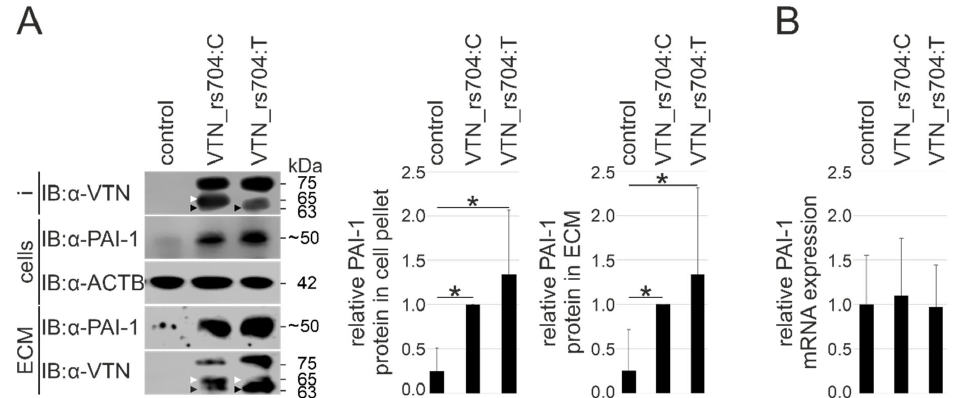
Figure 3. Effect of vitronectin isoforms on endogenous endothelial PAI ‐ 1 protein expression and deposition. HUVECs were incubated for 24 h with input (i) including VTN_rs704: C, VTN_rs704: T, or the same volume of control eluate (control), respectively. ( A ) Input, cells and ECMs were sub ‐ jected to immunoblot (IB) analysis with antibodies against vitronectin, PAI ‐ 1 and ACTB. Endoge ‐ nous PAI ‐ 1 is recognizable as a major molecular weight species of approximately 50 kDa, consistent with previous reports of glycosylated PAI ‐ 1 as a 50–54 kDa molecular weight species [46,47]. Ar ‐ rowheads indicate different fractions of recombinant vitronectin after its proteolytic cleavages (white arrows: cleavage between aa Arg398 and Ala399, black arrows: cleavage between aa Arg380 and Ser381) by endogenously expressed endoproteases. In contrast to VTN_rs704: C that stains as a mixture of a single polypeptide chain (about 75 kDa) and a clipped form (two chains of 65 and 10 kDa, held together by disulfide bonds, with the 10 kDa chain not detectable within this experimental setup), VTN_rs704: T is less susceptible to the proteolytic cleavage at Arg398 ‐ Ala399 indicated by a higher proportion of the uncleaved 75 kDa protein [8,32]. Molecular weights of approximately 63 kDa (black arrows) depict vitronectin fragments resulting from cleavage at Arg380 ‐ Ser381, as de ‐ scribed in [50]. PAI ‐ 1 signals were densitometrically quantified and normalized against ACTB. Data represent the mean ± SD of nine biological replicates, calibrated against the PAI ‐ 1 signals obtained after VTN_rs704: C addition. Asterisks indicate statistically significant differences (* p < 0.05, Krus ‐ kal–Wallis test, followed by Dunn’s multiple comparison test with Bonferroni correction). ( B ) mRNA was isolated and PAI ‐ 1 expression determined by qRT ‐ PCR. Data represent the mean ± SD of six biological replicates, calibrated against the control. Furthermore, the effect of VTN_rs704: C and VTN_rs704: T on PAI ‐ 1 deposition to the ECM was also explored in an alternative cell type: the RPE ‐ derived cell line ARPE ‐ 19 [51]. Cells were transfected with expression vectors for the two untagged vitronectin isoforms, or with an empty control vector, and incubated on transwell filters for 8 weeks. After immunolabeling, decellularized ECM produced by ARPE ‐ 19 cells heterologously expressing vitronectin showed an approximately 3 ‐ fold increase in PAI ‐ 1 protein expres ‐ sion (3.03 ± 1.73 with VTN_rs704: C, 2.59 ± 0.91 with VTN_rs704: T, compared to control; Bonferroni ‐ adjusted p < 0.05 between control and VTN_rs704: C or VTN_rs704: T; Figure 4). The ECMs revealed an increased accumulation of vitronectin (Figure 4), which was significantly more pronounced for the VTN_rs704: T isoform than for VTN_rs704: C (1.99 ± 0.90 ‐ fold increase; p < 0.05), in line with our previous findings in ECM depositions of transfected ARPE ‐ 19 cells after 4 weeks of cultivation [8].